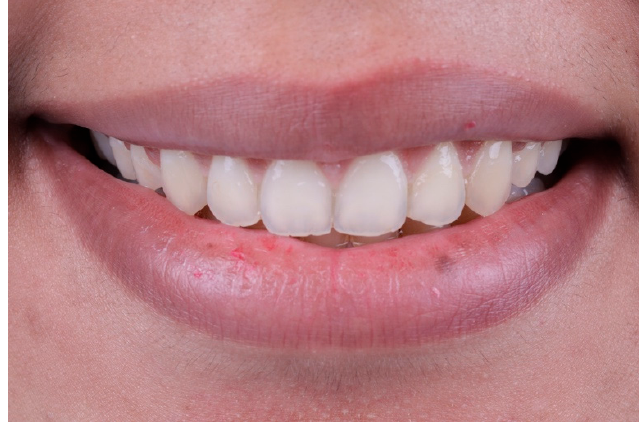
Figure 11. Intra oral view (6 months after surgery).